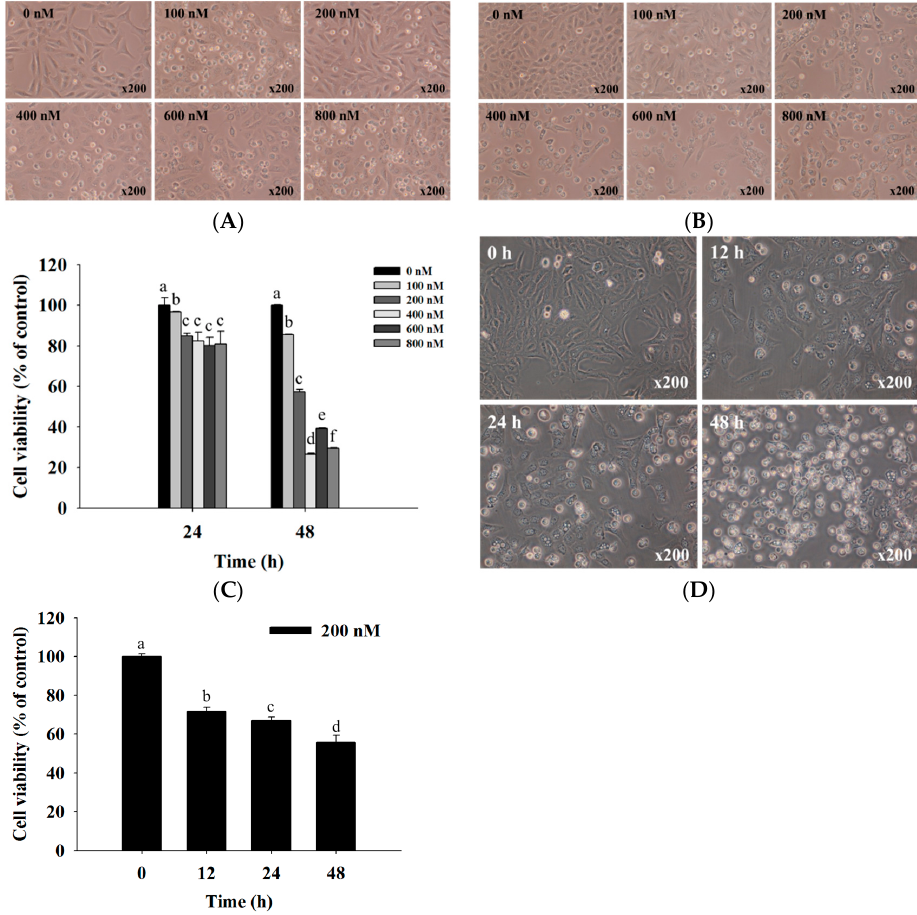
Figure 1. Bufalin induced cell morphological changes and decreased the viability of U-2 OS cells. Cells were treated with 0, 100, 200, 400, 600, and 800 nM of bufalin for ( A ) 24 h and ( B ) 48 h before the cells were examined and photographed for cell morphological changes by contrast-phase microscopy at ×200 and ( C ) were harvested for total percentage of viable cells measurements; or ( D ) were treated with 200 nM bufalin for various time periods before the cells were examined and photographed for cell morphological changes by contrast-phase microscopy at ×200; and ( E ) were harvested for total percentage of viable cells measurements. Morphological changes and total viable cells were observed by flow cytometry, as described in Materials and Methods. Different letters mean significant difference between bufalin-treated groups and the control as analyzed by one-way analysis of variance (ANOVA), followed by Duncan’s multiple range test